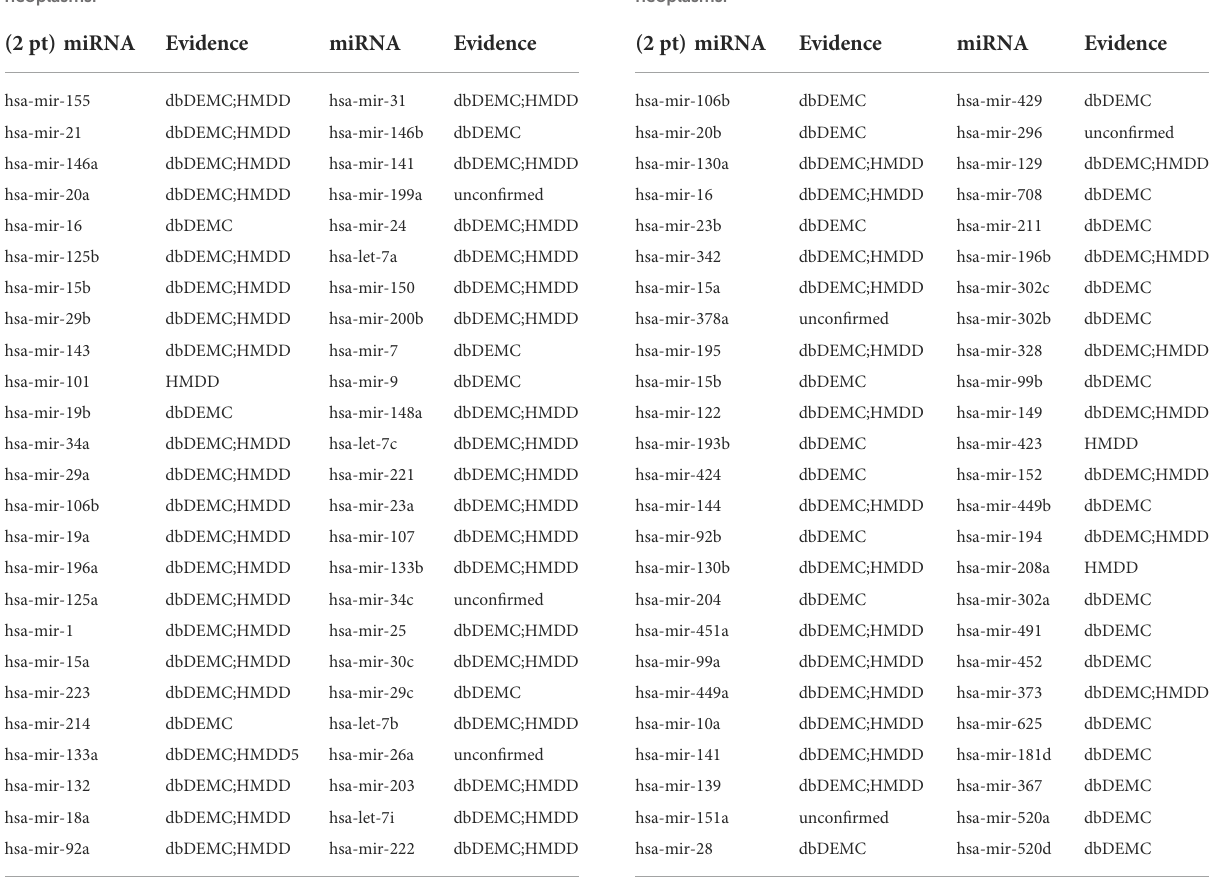
TABLE 1 The top 50 potential miRNAs associated with colon neoplasms.